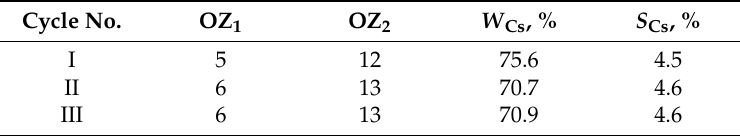
Table 6. Parameters for cesium ions elution—CT169.